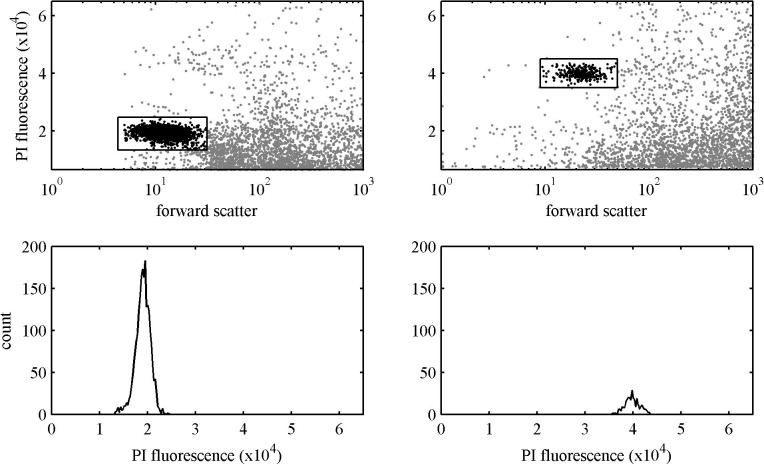
Flow cytometry graphs.The graphs on the left (A, C) represent an U. compressa gametophyte, while the two graphs on the right (B, D) represent an U. compressa sporophyte. Fig 2A and 2B show the forward scatter by fluorescence, while Fig 2C and 2D represent the count of nuclei from 20,000 events. The sporophyte (B, D) has twice the fluorescence as the gametophyte (A, C), with the gametophyte mean fluorescence near 19,000 and the sporophyte mean fluorescence near 38,000.